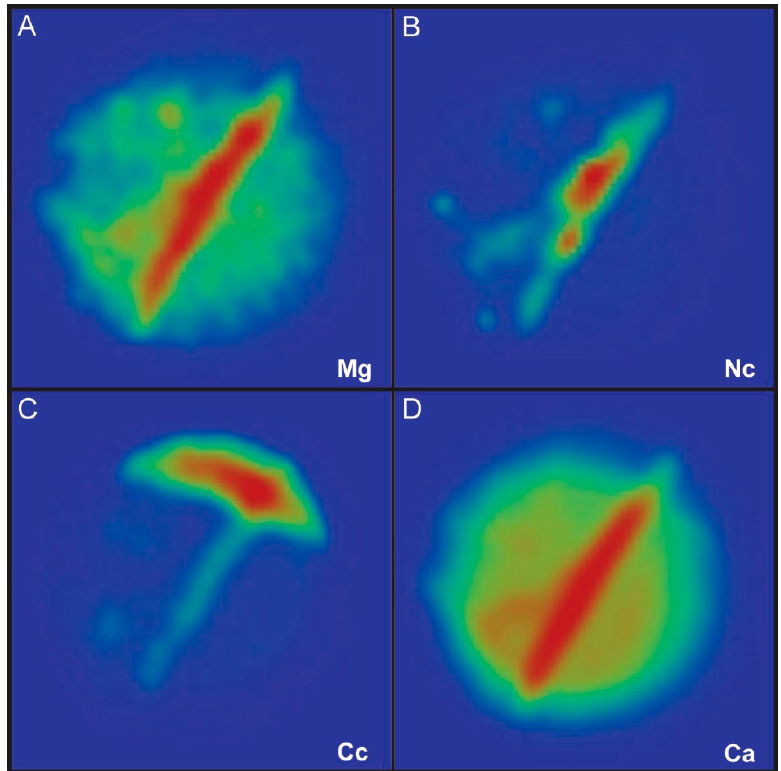
Figure 6. The 2D density contour plots taken from the entire specimen through the z -axis of the reconstructed volume (red equals the highest density) showing magnesium ( A ), nitrogen compounds ( B ), carbon compounds ( C ), and calcium ( D ) for tip M20 (W7). Nitrogen compounds follow the pattern of the high Mg and Ca density areas and cross a zone of high-density carbon compounds.